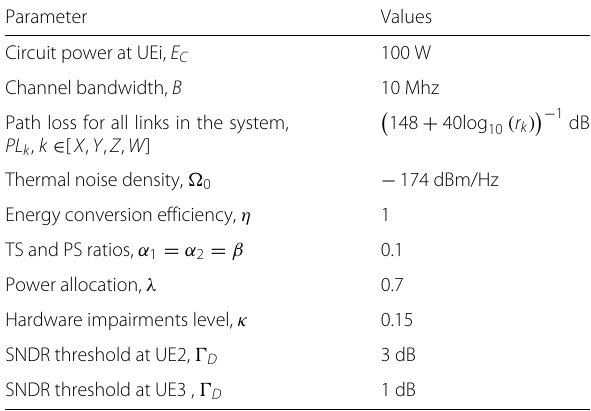
Table 2 Main simulation parameters Parameter